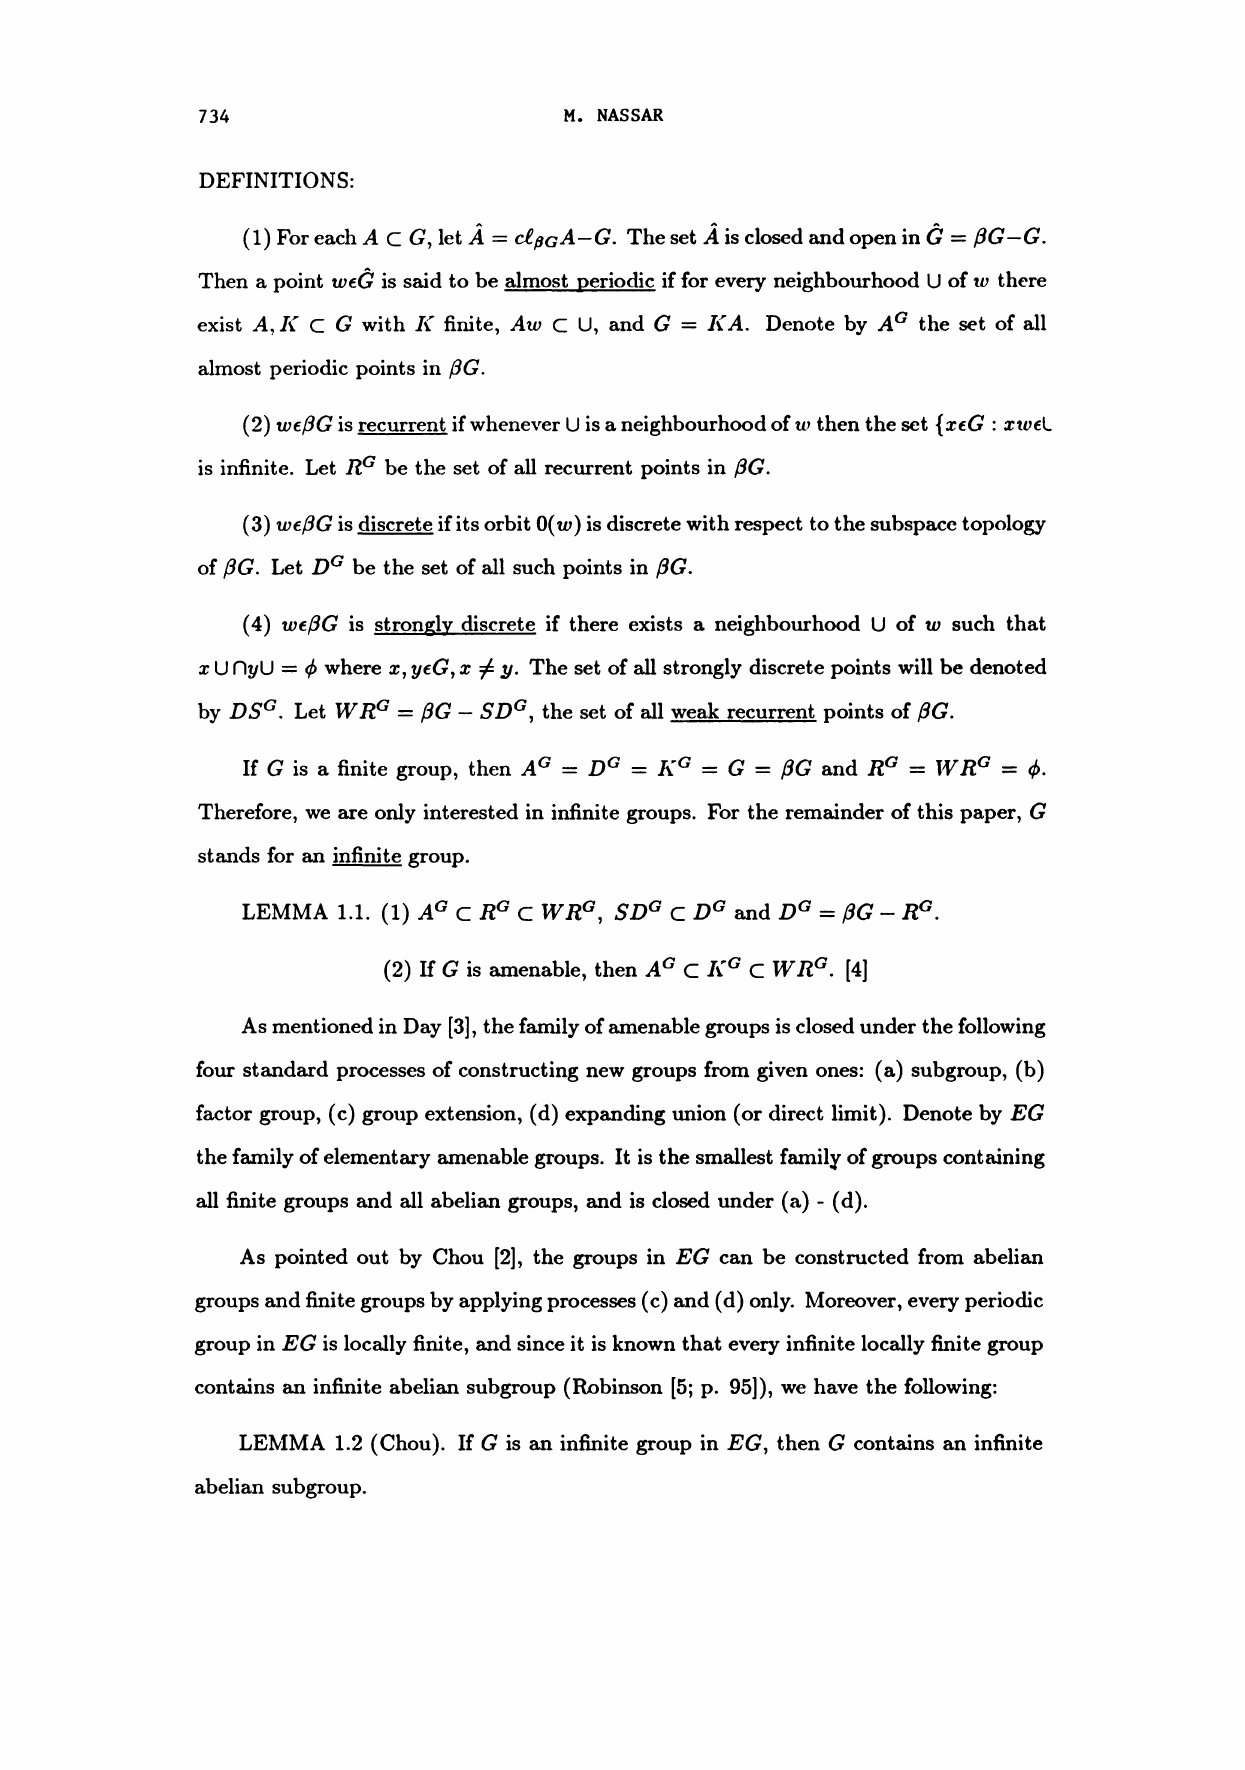
fig- SD G, the set of all weak recurrent points of/G.